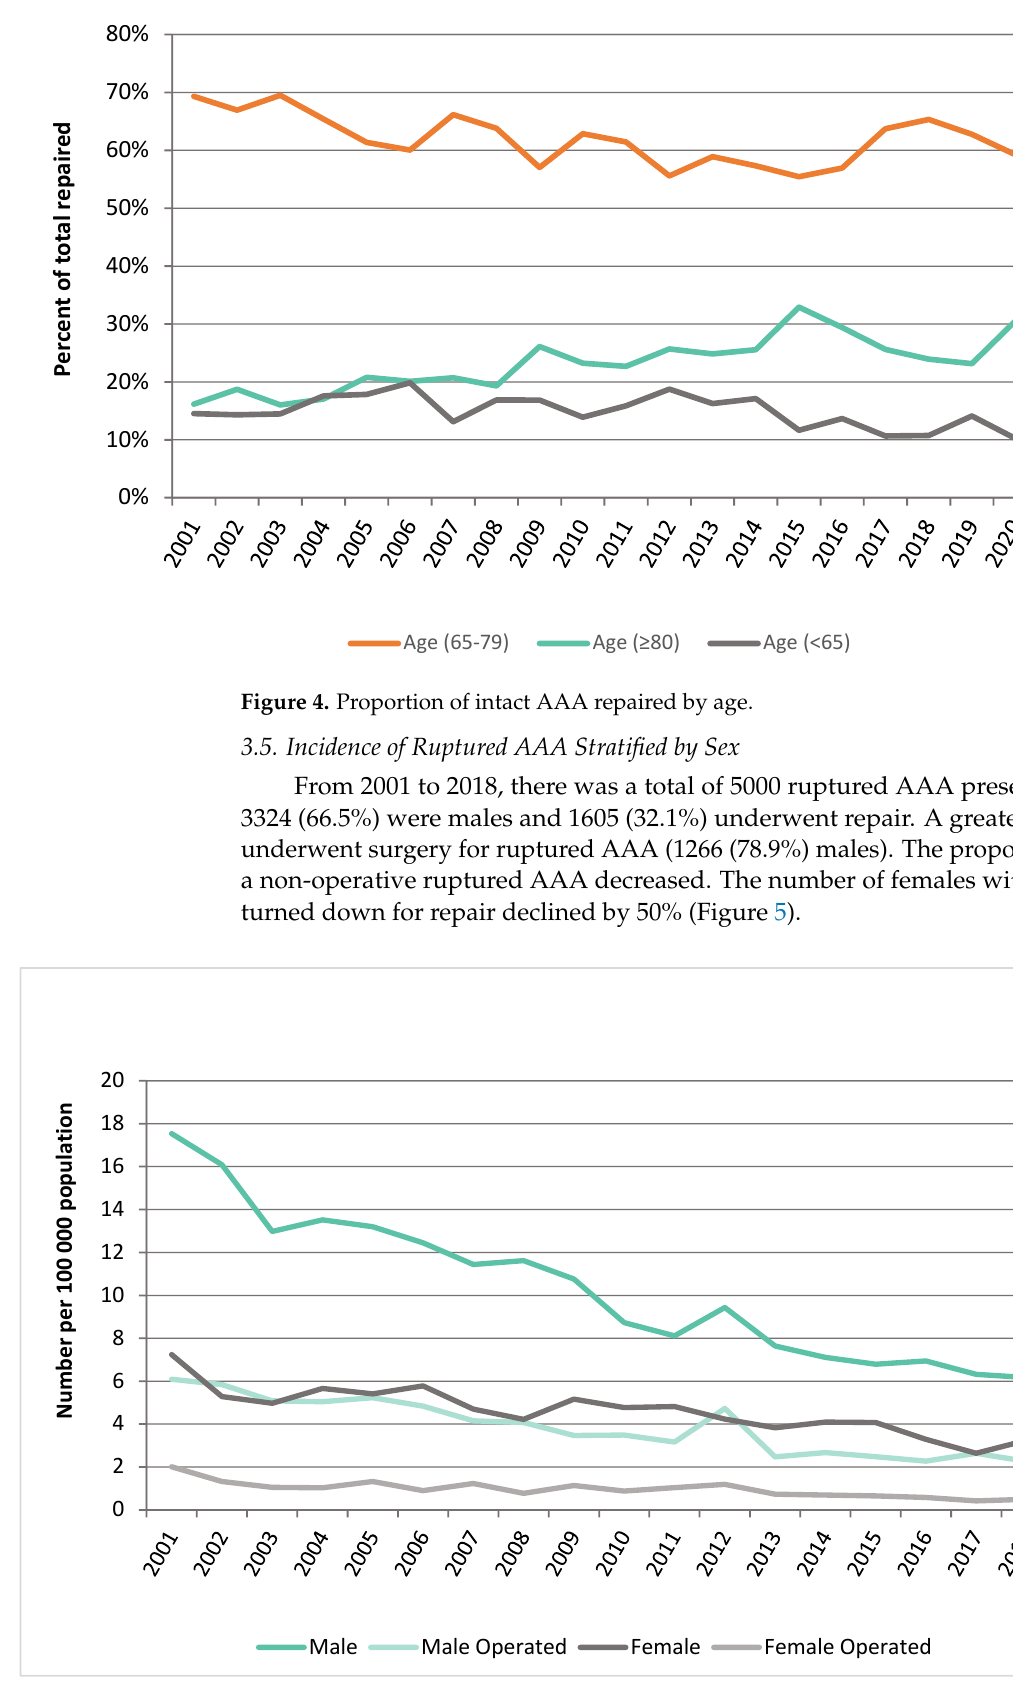
Figure 5. Trends or ruptured AAA incidence and repair between sexes.